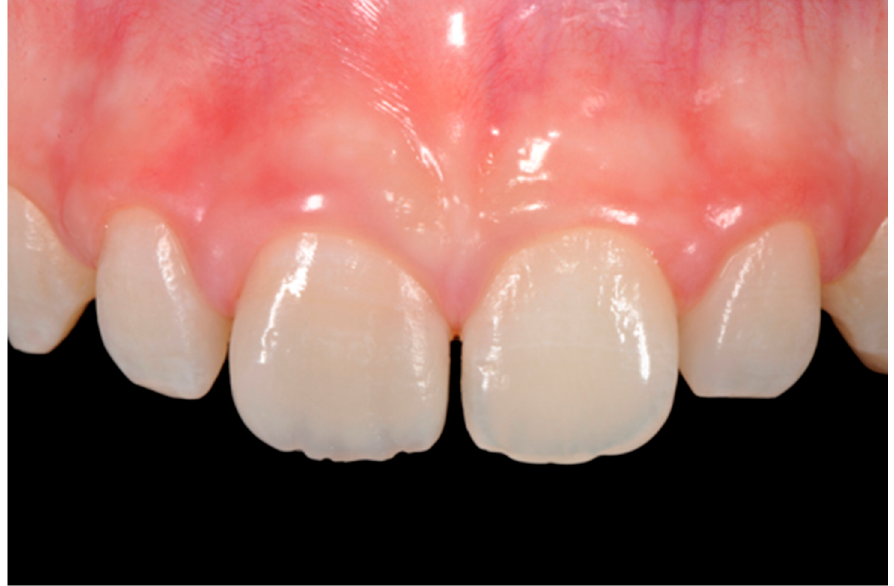
Figure 16. One year post-operative. Reprinted from Restauri diretti nei settori anteriori, G. Paolone, S. Scolavino, © 2021, with permission from Quintessence Publishing Italy.